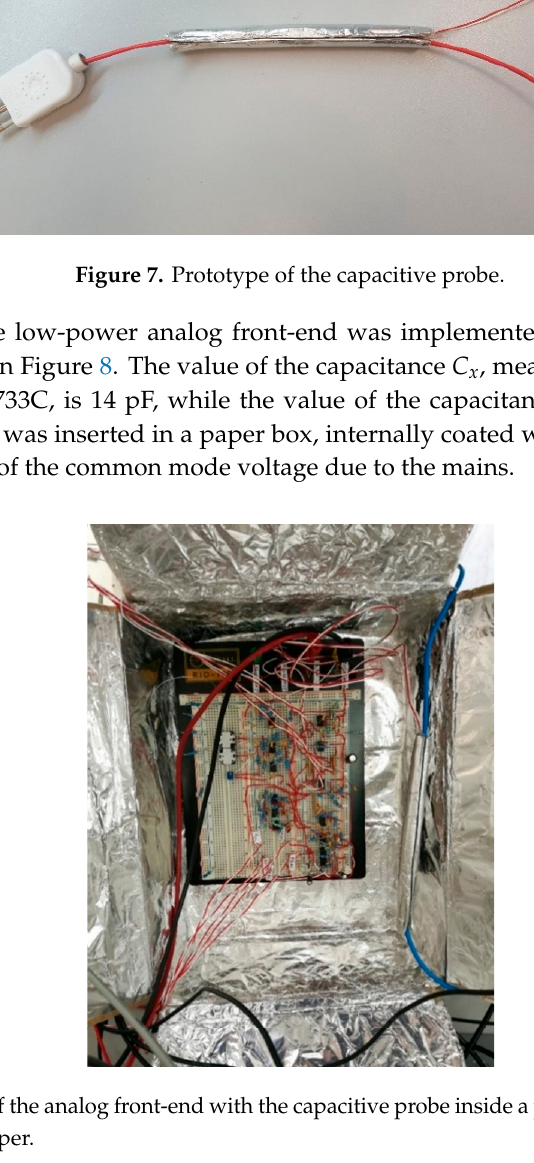
Figure 6. Schematic of the negative peak detectors.